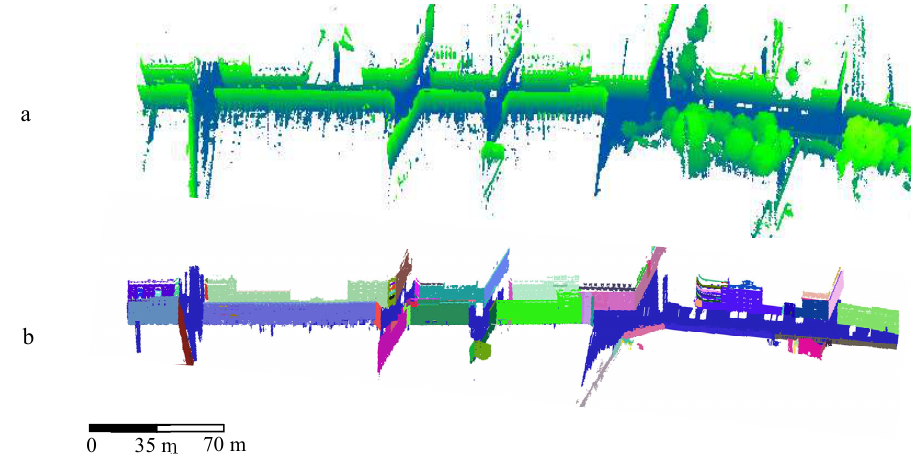
Figure 12. Mobile laser scanner data. ( a ) Mobile laser scanner point cloud obtained by the MATIS Laboratory, and ( b ) ground truth data obtained by manual segmentation.